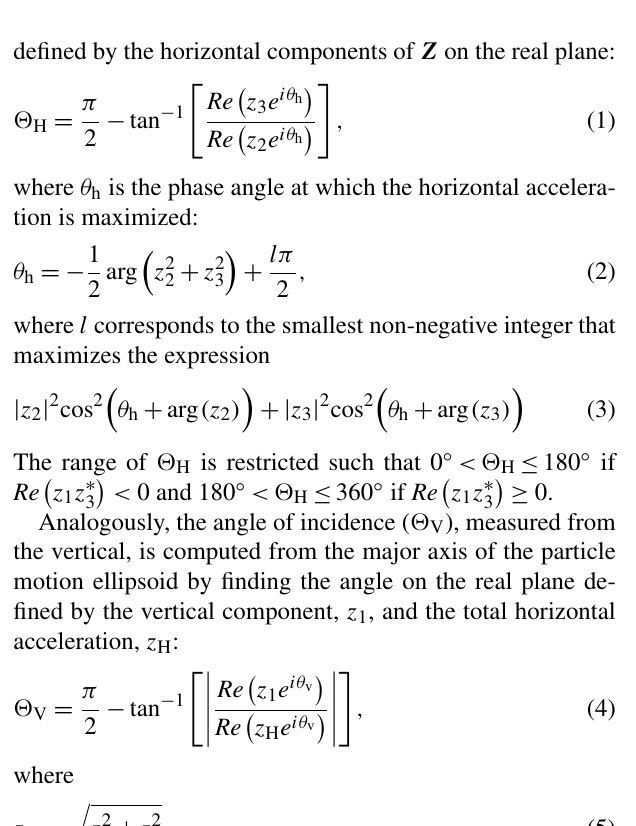
Figure 3. Diagram of particle motion defined by the dominant eigenvector. The particle motion at each frequency is analyzed by considering the dominant eigenvector of the spectral covariance ma- trix; the complex-valued components of this eigenvector can be vi- sualized as describing a particle motion in an ellipsoid (Park et al., 1987). The orientation of the eigenvector and the phase relation- ships between the components of the eigenvector yield the polariza- tion